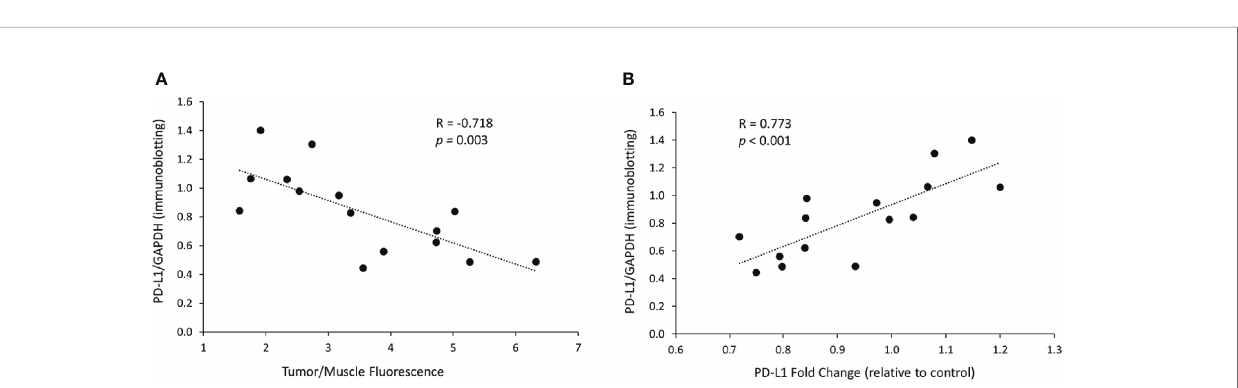
FIGURE 6 | In vivo PD-L1 protein levels decrease is related to dextran accumulation in the tumor and to mRNA changes. (A) Correlation between the PD-L1 protein levels, represented by immunoblotting intensity ratio of PD-L1 to GAPDH, and the tumor/muscle fl uorescence ratio in tumors treated with the siRNA/dextran complex. (B) Correlation between the protein levels of PD-L1, represented by immunoblotting intensity ratio of PD-L1 to GAPDH, and the levels of PD-L1 mRNA, represented by PD-L1 fold change relative to control, in tumors treated with the siRNA/dextran